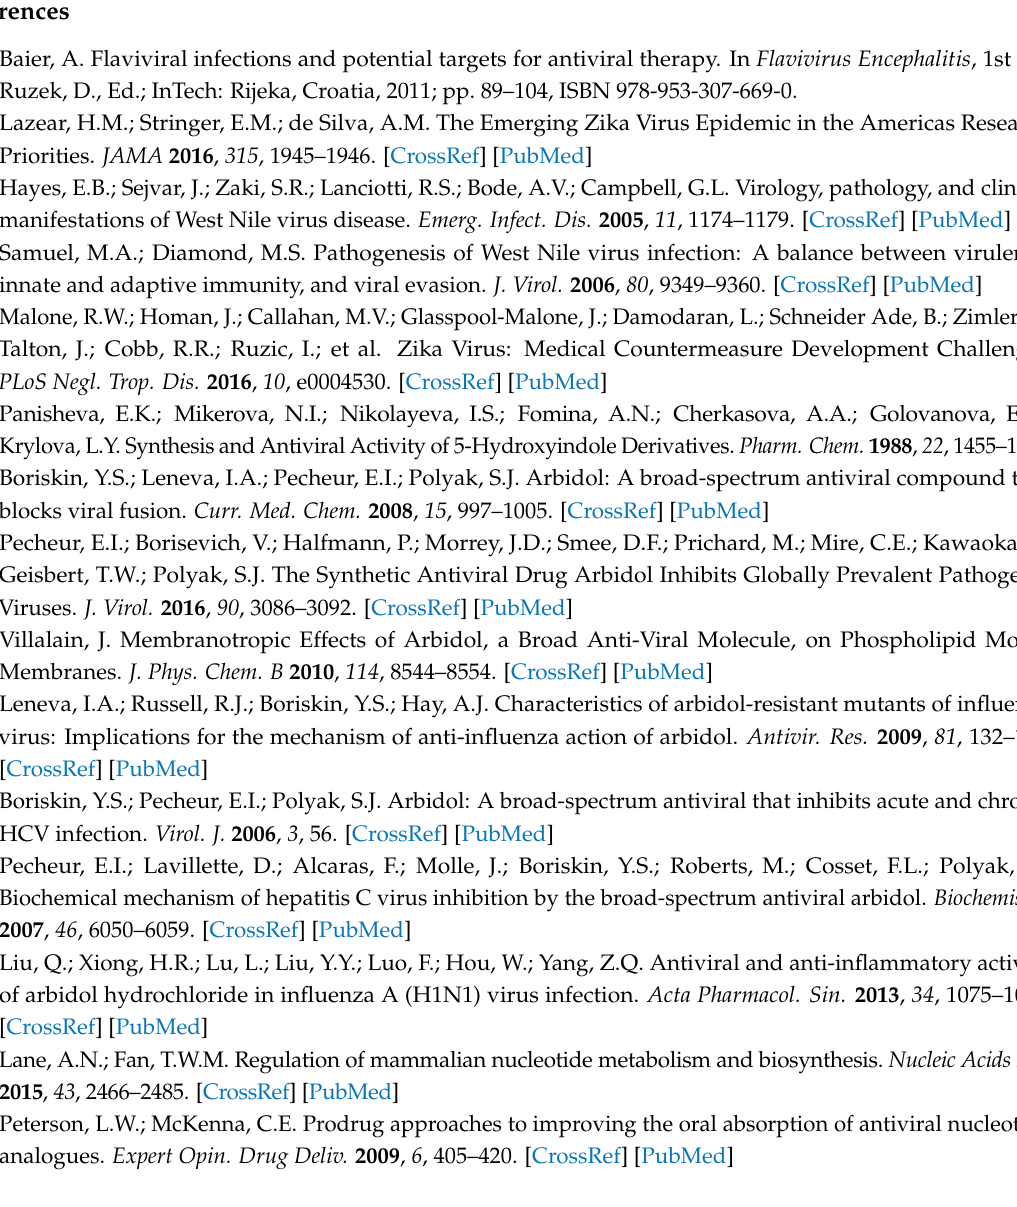
Figure S1: Growth curves of West Nile virus (WNV), Zika virus (ZIKV), and tick-borne encephalitis virus (TBEV) in Vero cells treated or mock-treated with